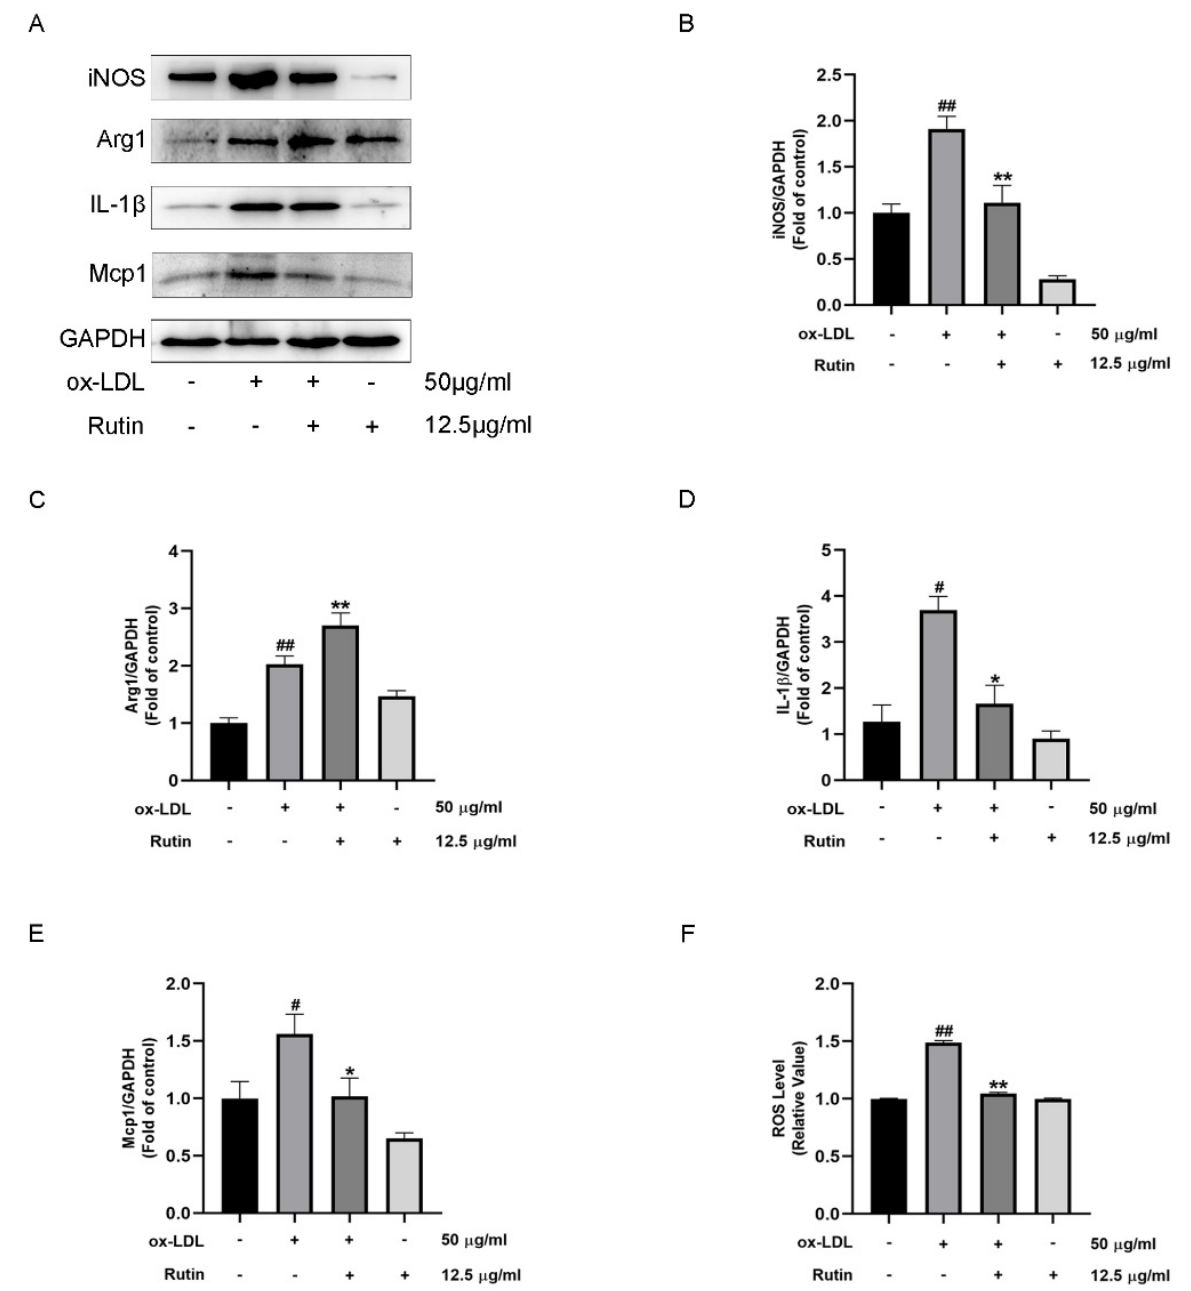
Figure 2. Rutin has the ability to reduce macrophage inflammation. RAW264.7 cells were stimulated for 24 h with 12.5 µ g/mL rutin with or without 50 µ g/mL ox-LDL therapy. ( A – E ) Western Blot was used to detect the expression levels of iNOS, ARG1, IL-1 β and Mcp1. ( F ) DCFH-DA staining was used to quantify intracellular ROS generation. # p < 0.05, ## p < 0.01 vs. control group; * p < 0.05, ** p < 0.01 vs. ox-LDL-treated group. All data are shown as the mean ± SD of three independent trials, each of which was carried out in triplicate.